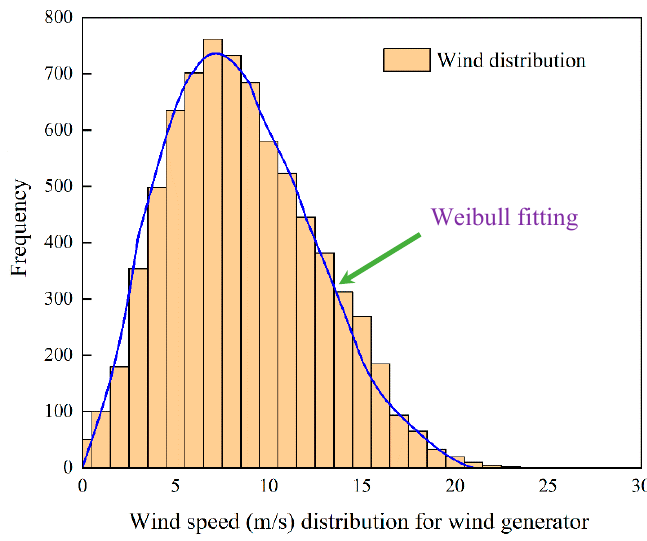
Figure 2. The distribution of wind speed through the Monte Carlo simulation.